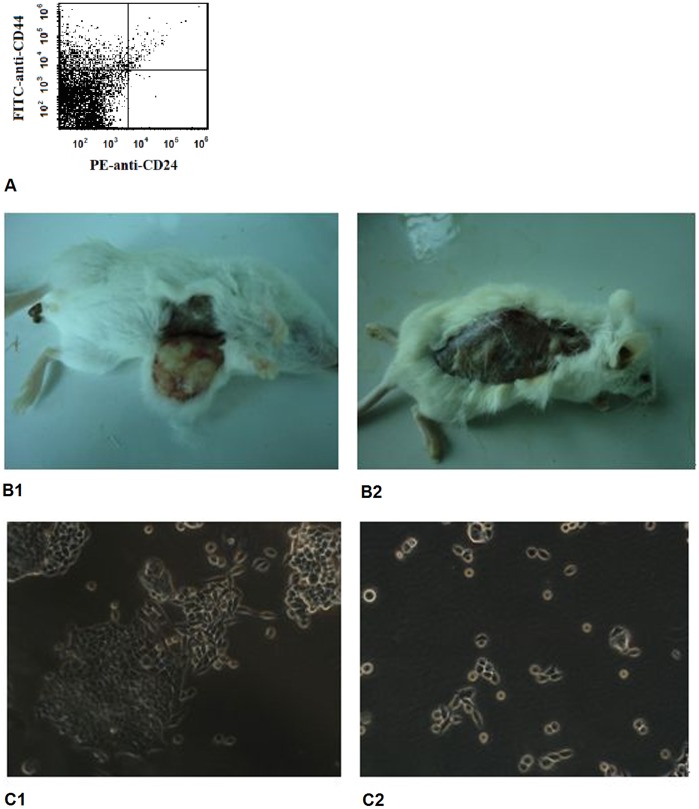
CD44+/CD24- tumor cells got a strong ability to form solid breast tumors and mammospheres.A representative FACS plots to demonstrate the CD44+/CD24- cancer stem cells (A) and a representative tumor in the NOD/SCID mouse showed at the CSC-cell injection site (B1), but not at the non-CSC cell injection site (B2). CSC cells can form mammospheres in the non-adherent culture condition (1-week culture) (C1), whereas no mammosphere was produced in non-CSC cells (C2).